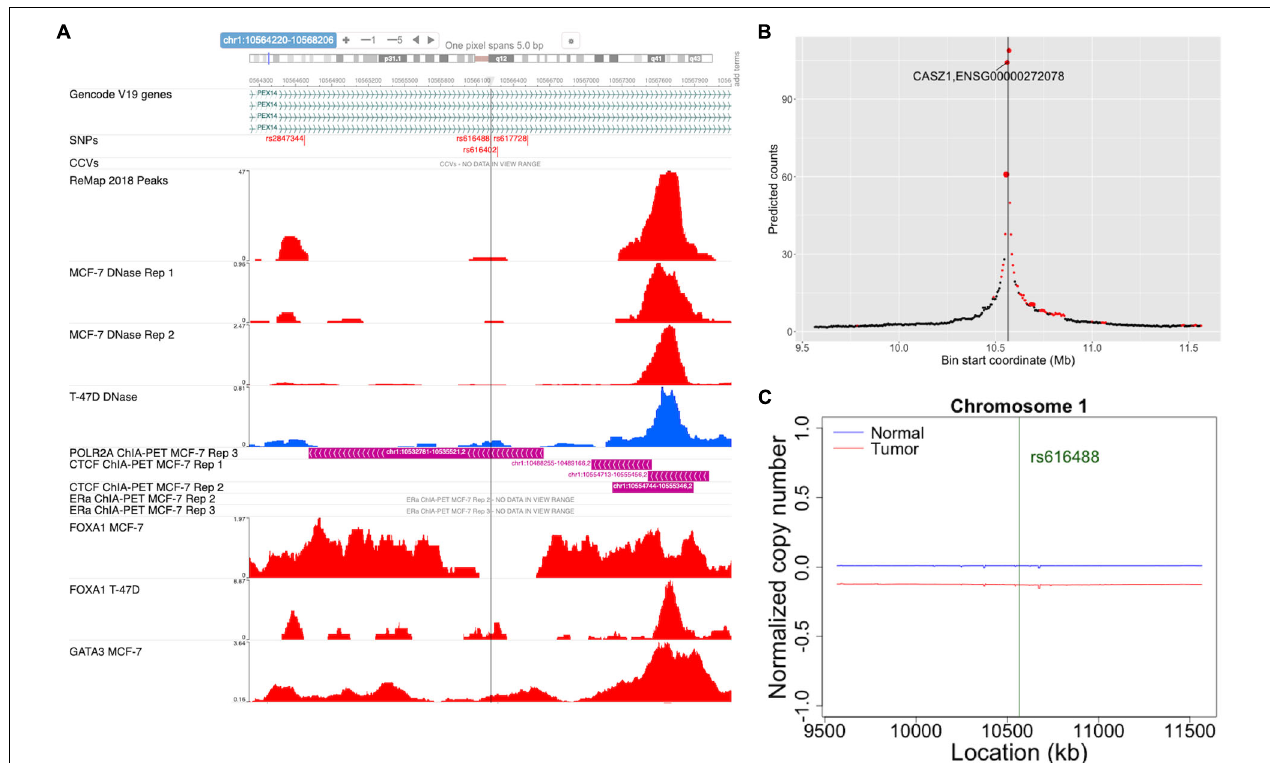
FIGURE 3 | Snapshots of some of the ABC-GWAS analysis modules. (A) Embedded genome browser showing the queried LD SNP location (vertical line) and ChIP-seq tracks in MCF-7 and T-47D cell lines. The “SNPs” track shows the locations of the GWAS SNPs and high LD SNPs, while the “CCVs” track shows the locations of the credible causal variants and their GWAS lead SNPs. (B) The plot shows average predicted chromatin contact counts across several HiC-Reg models in MCF-7 as a function of genomic location centered at the queried LD SNP (vertical line). The predictions for which at least one model shows significance ( q < 0.05) is filled in red. The size of the markers is proportional to the number of models showing significance. (C) Normalized DNA copy number for normal (blue) and tumor (red) samples from TCGA in a 2 Mb window centered at the GWAS SNP